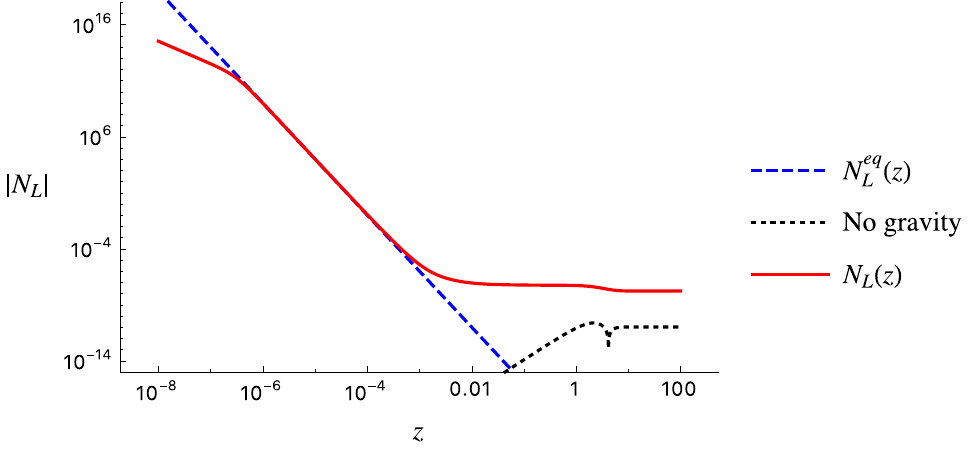
Figure 15 . Dynamical evolution of the lepton number asymmetry N L ( z ) in the case of a hierarchy enhancement, p = 1, with parameters chosen so that the gravitational leptogenesis mechanism dominates over the out-of-equilibrium (cid:23) 1 decays. Here, M 1 = 5 (cid:2) 10 10 GeV, K = 1, with M 3 = R 10 16 GeV, Im K 13 = (4 (cid:25) ) 2 = 5 (cid:2) 10 (cid:0) 4 and " 1 = 10 (cid:0) 10